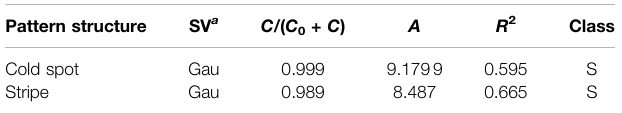
TABLE 6 | Fitted semivariogram models (SV) and its characteristic parameters for different prey pattern ( Figure 6 ). The meanings of other parameters are consistent with Table 2 .